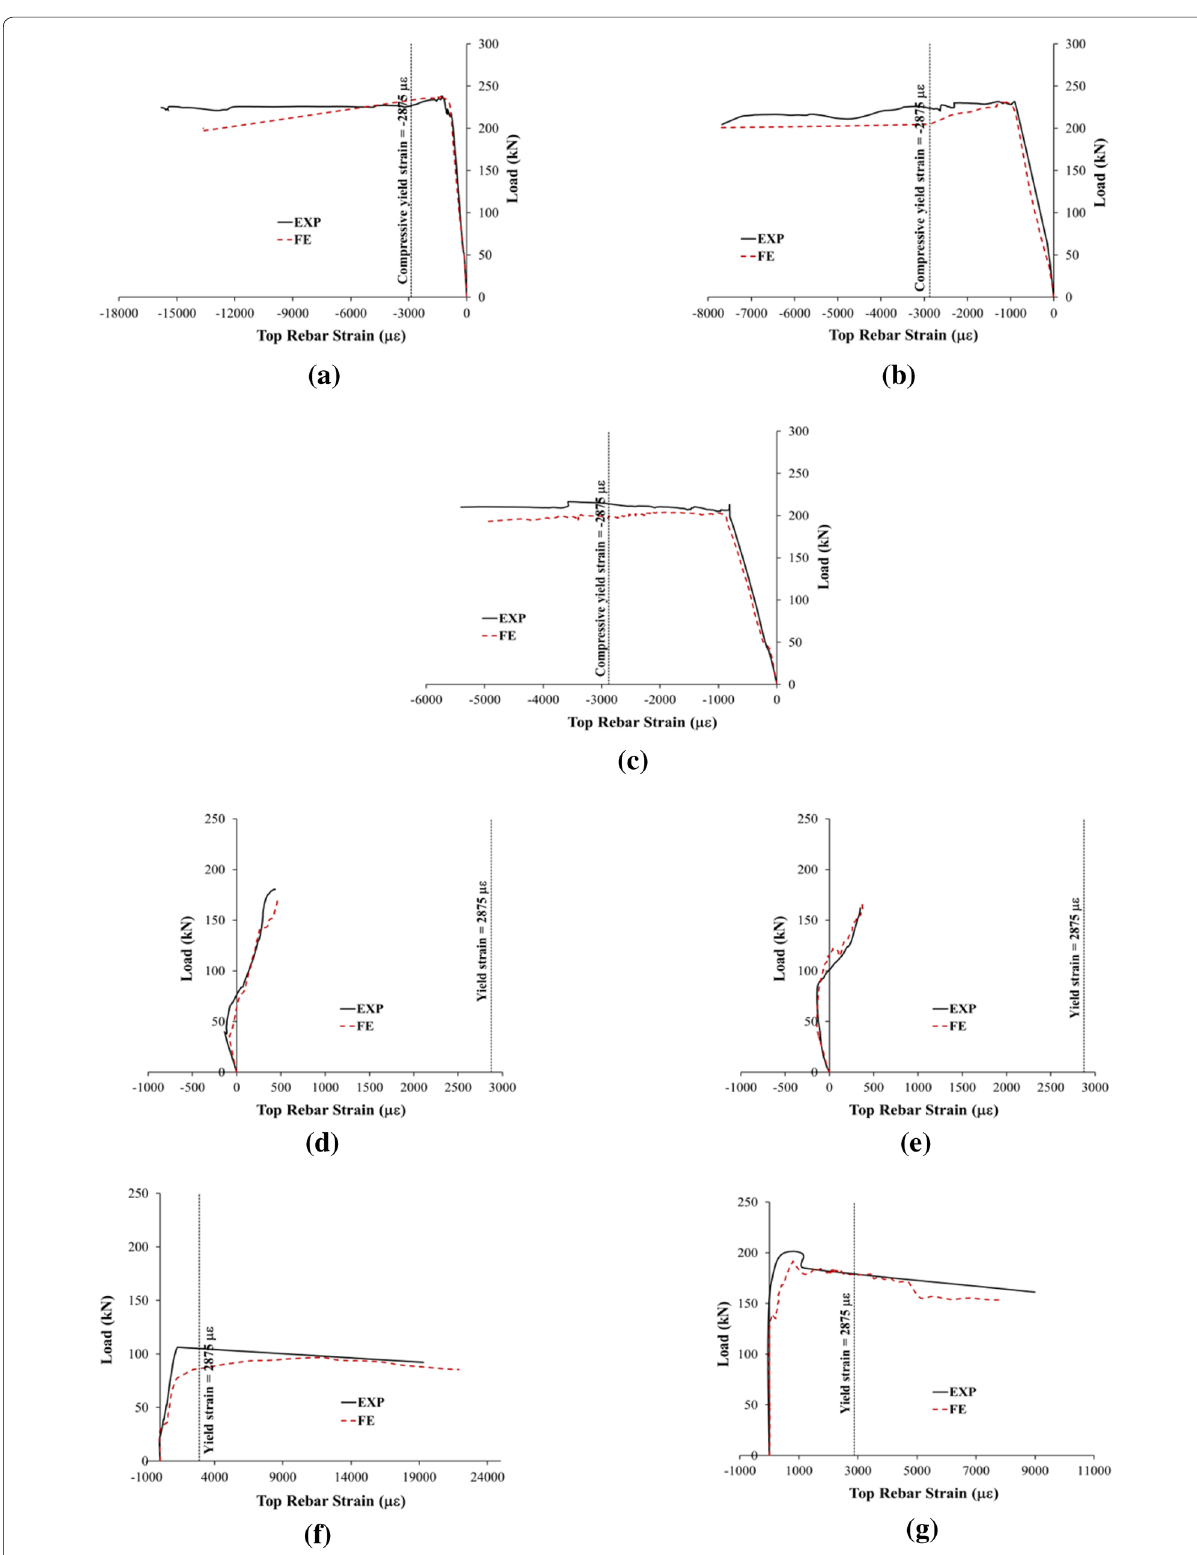
Fig. 15 Comparison curves of experimental and FE load versus strain of top rebars at mid‑span of: a BC‑N‑4PB, b BC‑O1‑4PB, c BC‑N‑CPL, d BC‑O1‑CPL, e BS1‑O1‑CPL, f BC‑O2‑CPL, and g